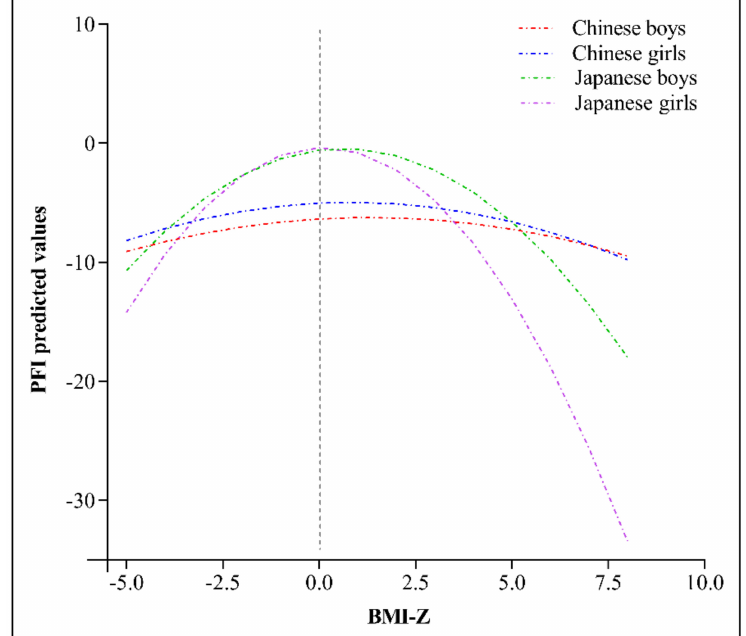
Figure 5. Relationship between PFI and BMI-Z score among boys and girls in China and Japan. Equations were listed as following: PFI (Chinese boys) = − 0.072 × BMI-Z 2 + 0.187 × BMI-Z − 6.363; PFI (Chinese girls) = − 0.094 × BMI-Z 2 + 0.157 × BMI-Z − 5.042; PFI (Japanese boys) = − 0.323 × BMI-Z 2 + 0.408 × BMI-Z − 0.576; PFI (Japanese girls) = − 0.531 × BMI-Z 2 + 0.114 × BMI-Z −